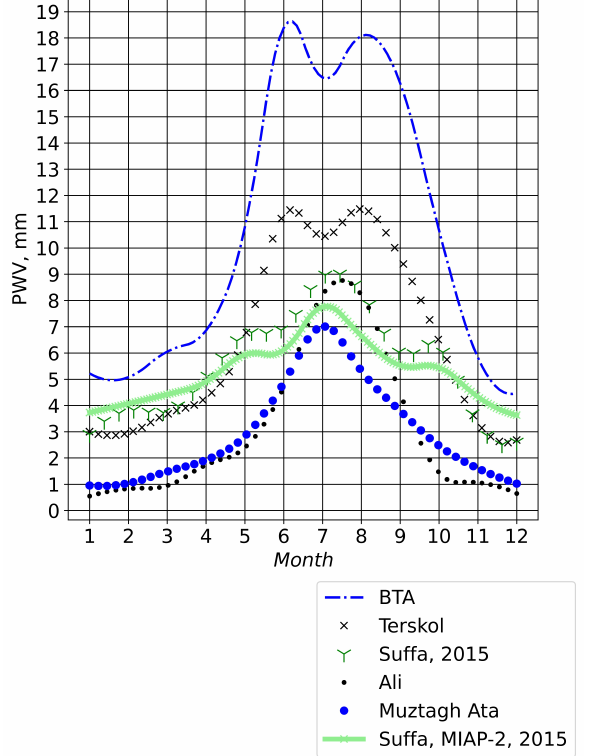
Figure 12. Seasonal changes in corrected median PWV values estimated from Era-5 reanalysis data at the sites of Ali, Muztag-Ata, Suffa, Bta and Peak Terskol.